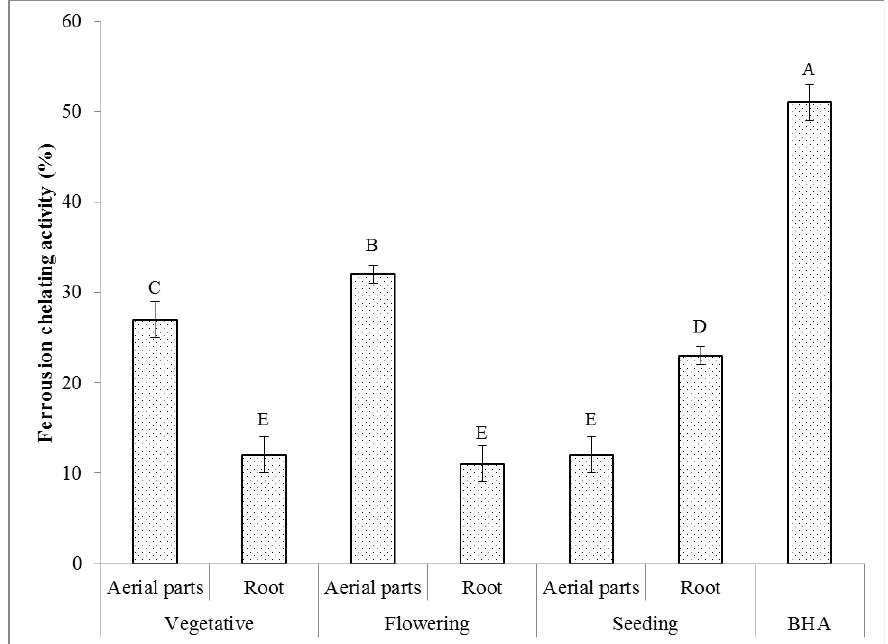
Figure 5. Ferrous ion chelating activity ( n = 3) of the extracts of the T. polium aerial parts and root at different phenological stages. The extract concentration is 200 µg/mL. Various letters indicate statistically significant differences ( p < 0.05).